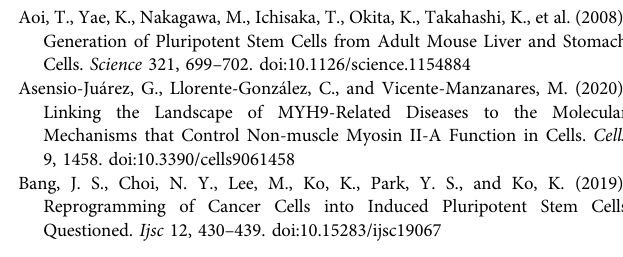
Frontiers in Bioengineering and Biotechnology |